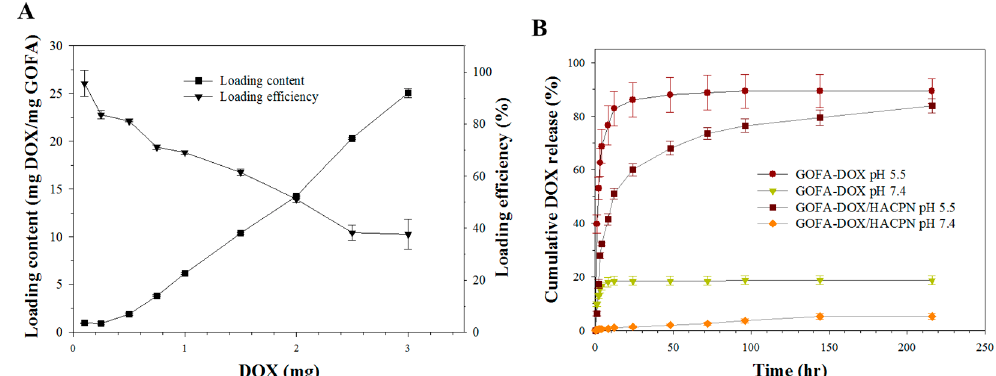
Figure 4. The loading and release of DOX. ( A ) Drug loading efficiency and drug loading content when 0.1 mg GOFA was reacted with different amount of DOX; ( B ) Drug release from GOFA-DOX and GOFA-DOX/HACPN at pH 7.4 and pH 5.5 in PBS (37 °C).